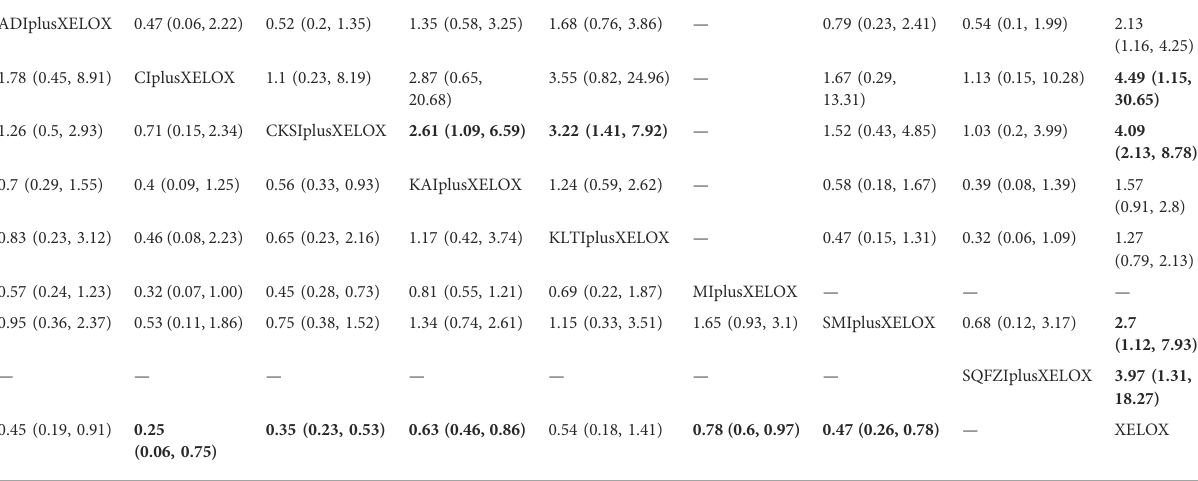
The values in bold are values with statistical analysis signi fi